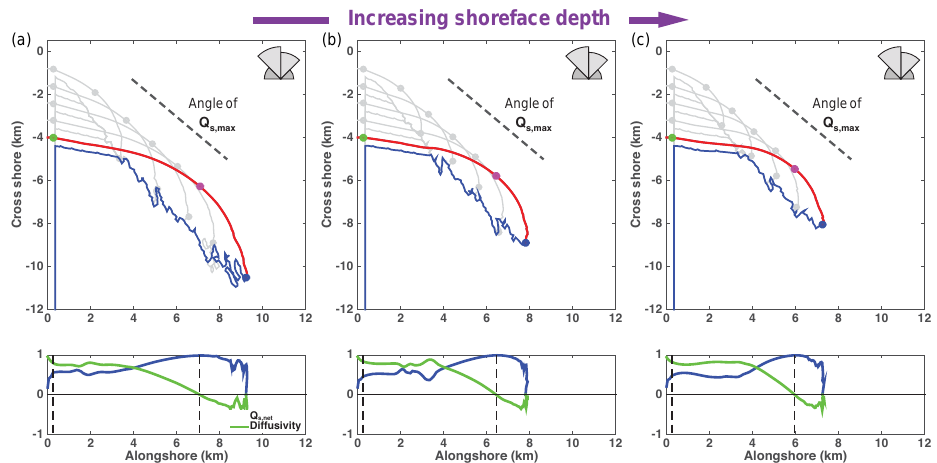
Figure 13. Plan views of modeled spits extending off of a headland eroding at a fixed rate of 0.08mday − 1 after 137 model years. The only difference between simulations is the shoreface depth and concomitant basin depth: (a) D = 10m, (b) D = 15m, and (c) D = 20m ( A = 0 . 6 , U = 0 . 2). Plot features explained further in Fig. 4